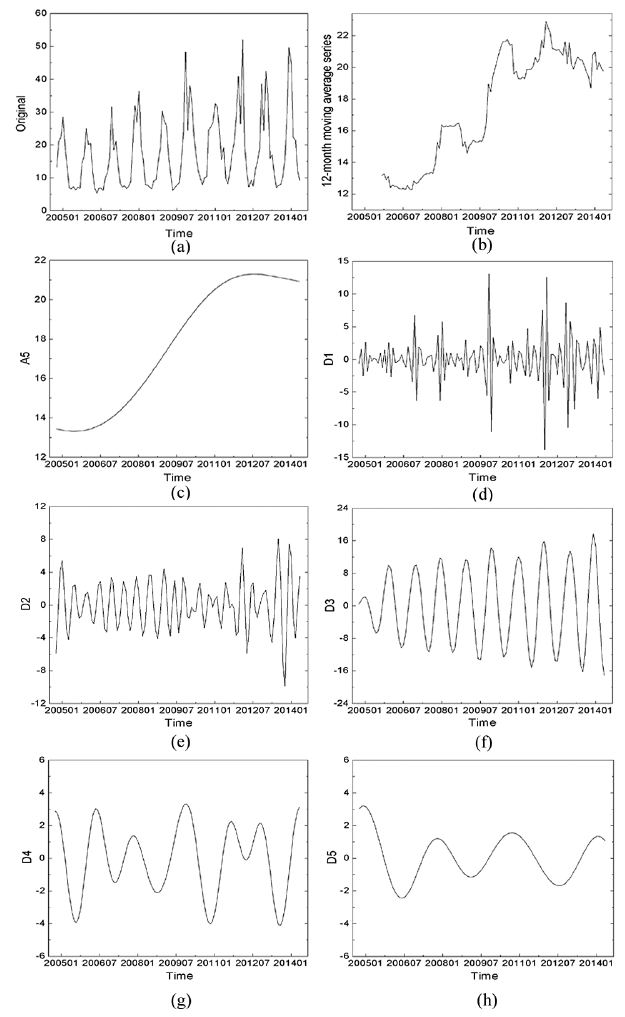
Figure 3. An example of the 5-level wavelet decomposition. (a) The original monthly time series of OMI NO 2 at a grid cell in Xi’an (34.5 ◦ N, 108.9 ◦ E), (b) the 12-month moving average time series, (c) the approximation signal A 5 representing the long-term trend, (d–h) five decomposition levels D 1 – D 5 indicating temporal vari- ability at various